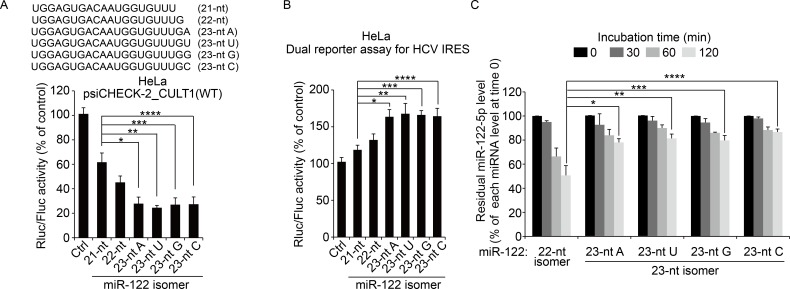
Analysis of the activity and stability of miR-122 isomers.(A) A reporter assay was performed 48 h after the transfection of duplex forms of the indicated miR-122 isomers or scrambled siRNA (Ctrl) and the reporter plasmid psiCHECK-2_CULT1(WT) harboring a miR-122 target. Shown is the normalized luciferase activity (Rluc/Fluc) compared with the scrambled siRNA-transfected control. *P = 0.02; **P = 0.017; ***P = 0.034; and ****P = 0.037. (B) HeLa cells were co-transfected with duplex forms of the indicated miR-122 isomers and a dual luciferase reporter allowing HCV IRES-mediated Rluc translation. After 48 h, transfected cells were harvested, and the relative normalized luciferase activity (Fluc/Rluc) was measured as described in Fig 2E. *P = 0.002; **P = 0.0017; ***P = 0.0034; and ****P = 0.0037. (C) Improved stability of 23-nt miR-122 isomers compared with the most abundant, prototype 22-nt miR-122. Residual miR-122 guide strand abundance measured by northern blot analysis after incubation of individual duplex miR-122 isomers with HeLa cell extracts for the indicated periods. *P = 0.0012; **P = 0.0018; ***P = 0.0012; and ****P = 0.0013. In all panels, error bars are standard deviations of three independent experiments. P values were calculated using an unpaired t-test.